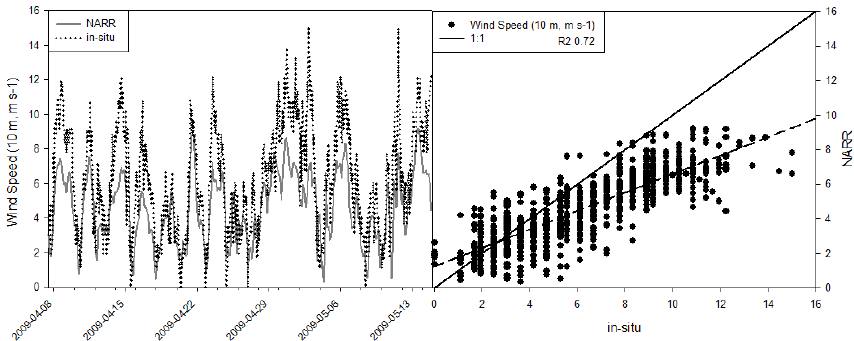
Figure 2. Wind speed (10m, ms − 1 ) for the observation period, and the relationship between NARR and in situ values.